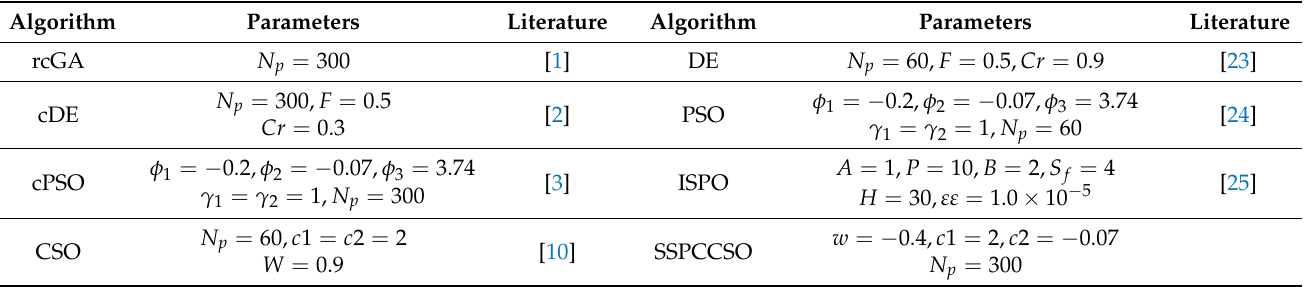
Table 1. Selected parameters list for all compared algorithms in this projection.